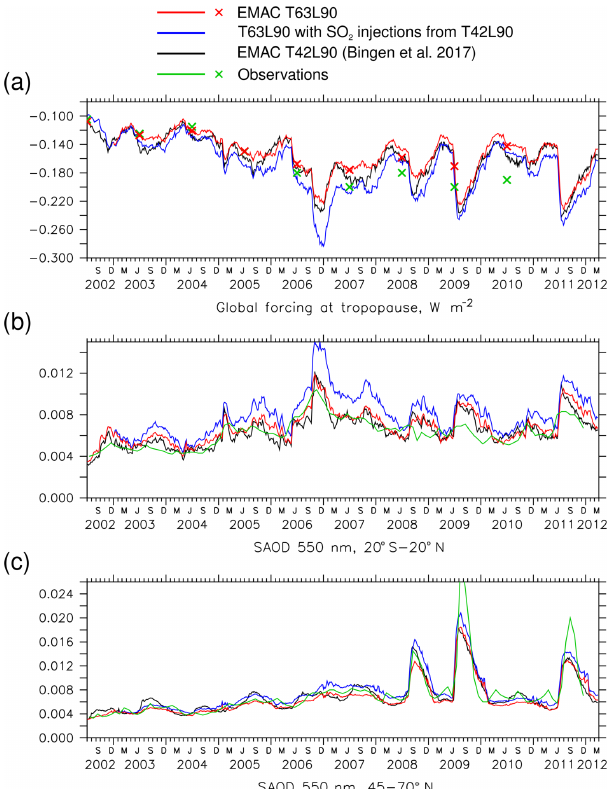
Figure 3. (a) Stratospheric aerosol radiative forcing, (b, c) strato- spheric AOD for tropics and midlatitudes. Red lines and crosses: EMAC, resolution T63L90, current version; black: EMAC T42L90 (Bingen et al., 2017); blue: T63L90 without downscaling the SO 2 injections for T42L90; green: from observations (crosses annual mean for forcing; Solomon et al., 2011; SAGE II, CALIPSO, OSIRIS).